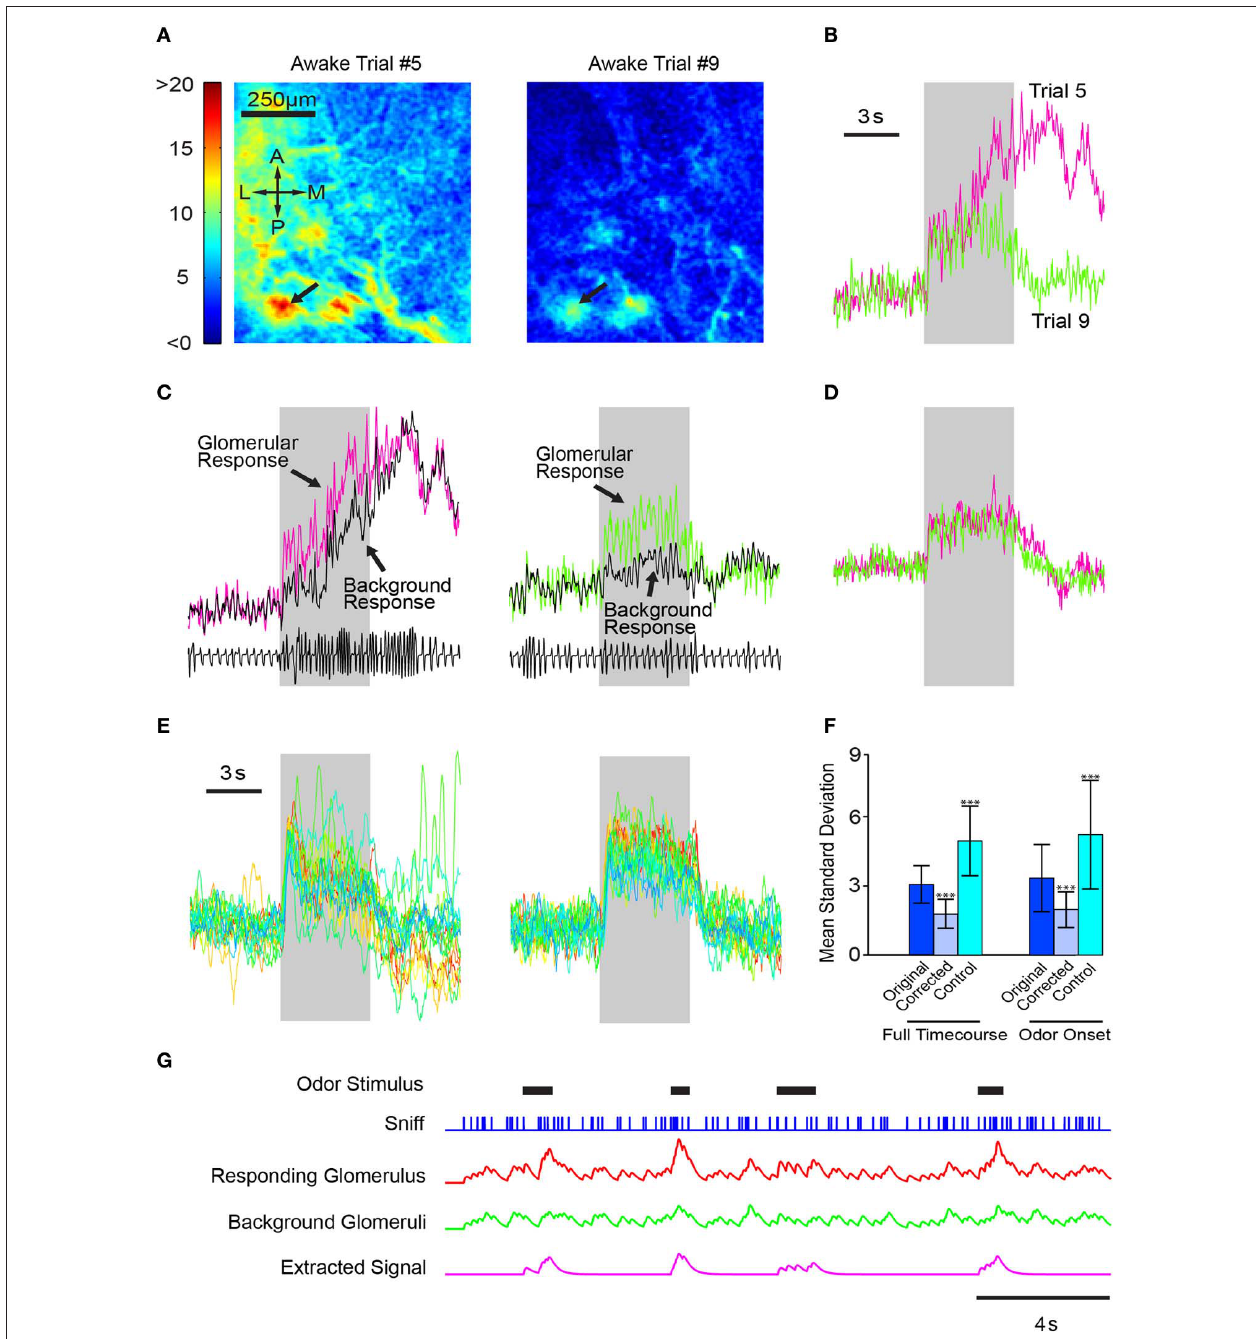
FIGURE 8 | Consistent response profiles in awake mice can be derived by subtracting whole-bulb responses. (A) Glomerular activation profiles in an awake mouse during two different trials (5 and 9, respectively) of 1% valeradehyde presentation. (B) Response profiles of the glomerulus indicated by the arrows in (A) . (C) Glomerular response profiles plotted with the whole dorsal-bulb background response. (D) Corrected glomerular response time courses obtained by subtracting the background response from the glomerular response. (E) Left, glomerular responses of 20 different trials of the same odor. Right, time courses of the same 20 trials after background subtraction. (F) Bar graph depicting the average standard deviation of each point in the time course across all trials of the same odor ( n = 6 mice,